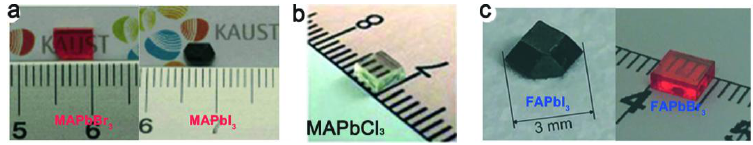
Figure 4. The inverse-temperature-crystallization method producing large-size crystals of ( a ) MAPbX 3 ( b ) MAPbCl 3 , and ( c ) FAPbX 3 . The figure was taken from refs [38–40] with permission.